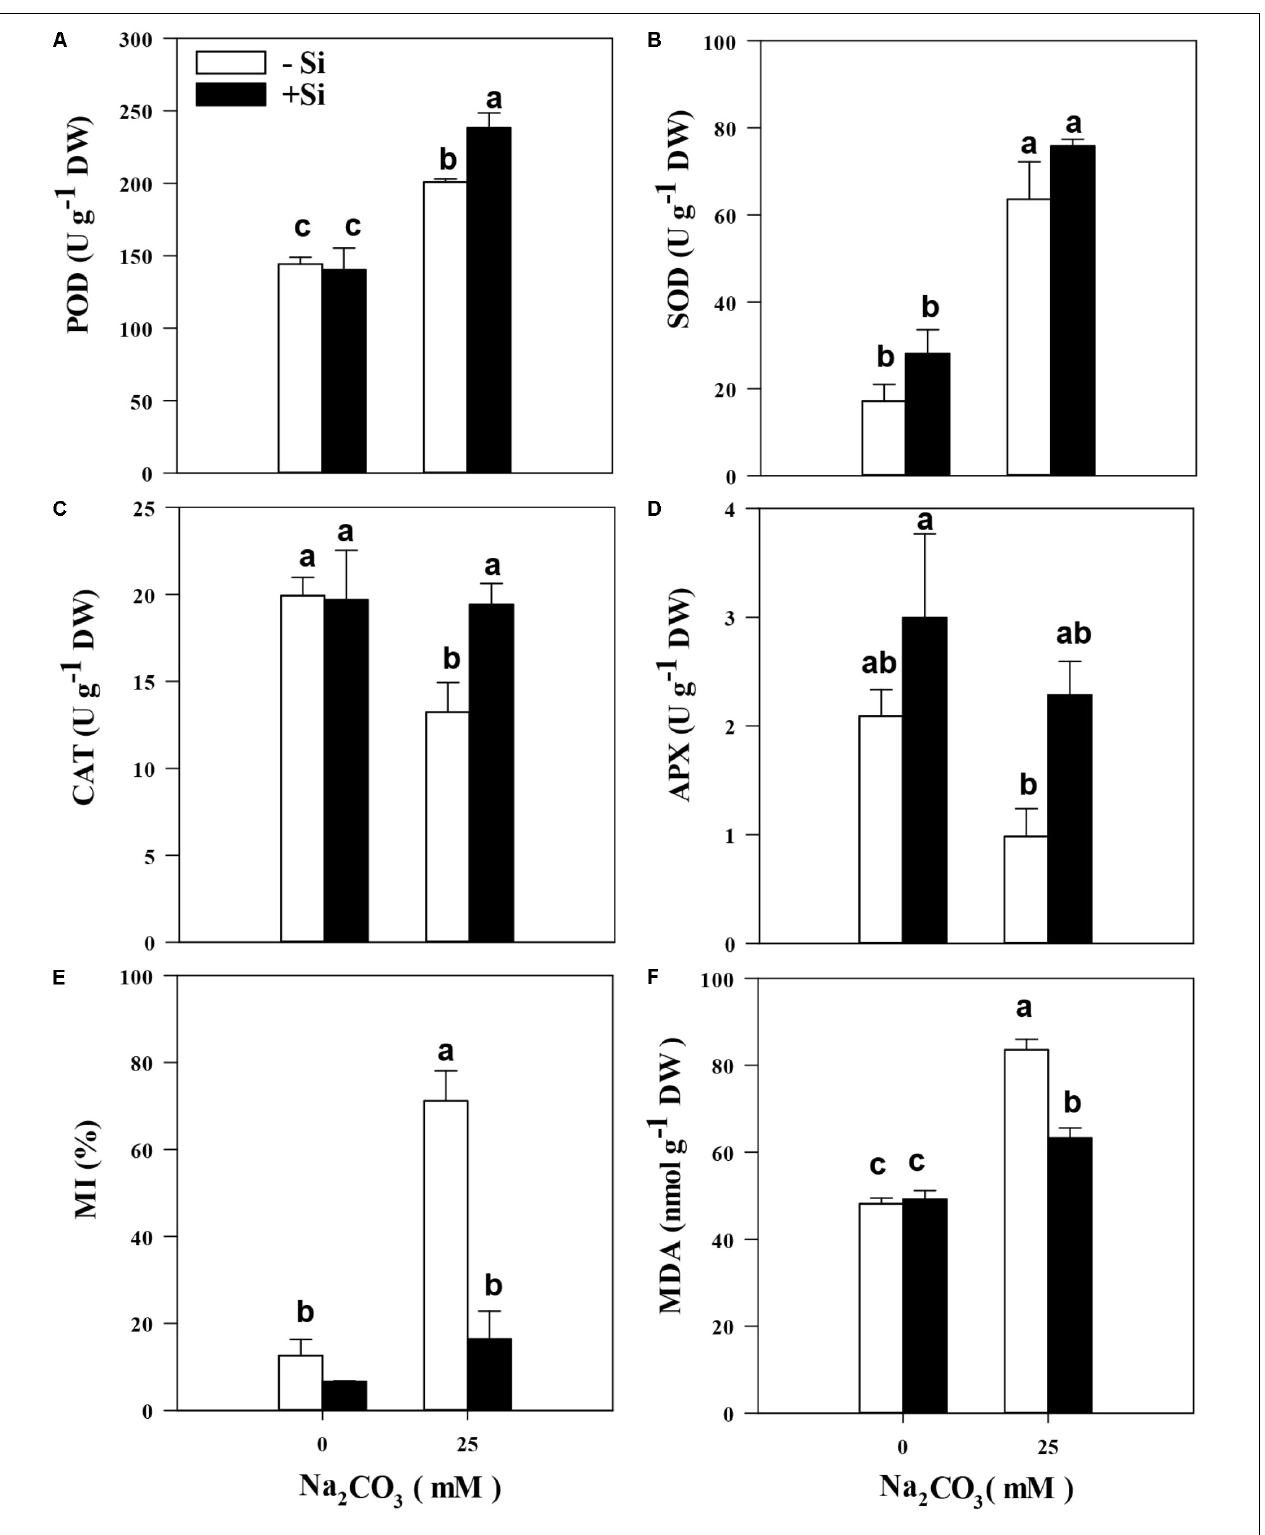
FIGURE 4 | Peroxidase (POD) activity (A) , superoxide (SOD) activity (B) , catalase (CAT) activity (C) , ascorbate peroxidase (APX) activity (D) , membrane injury (MI) (E) , and malondialdehyde content (MDA) (F) in the leaves of alfalfa seedlings under Si priming in response to alkaline stress. –Si = pretreatment without Si; +Si = pretreatment with Si. Values are means ± SE, n = 25. Different letters denote significant difference ( P < 0.05) based on Duncan’s test.